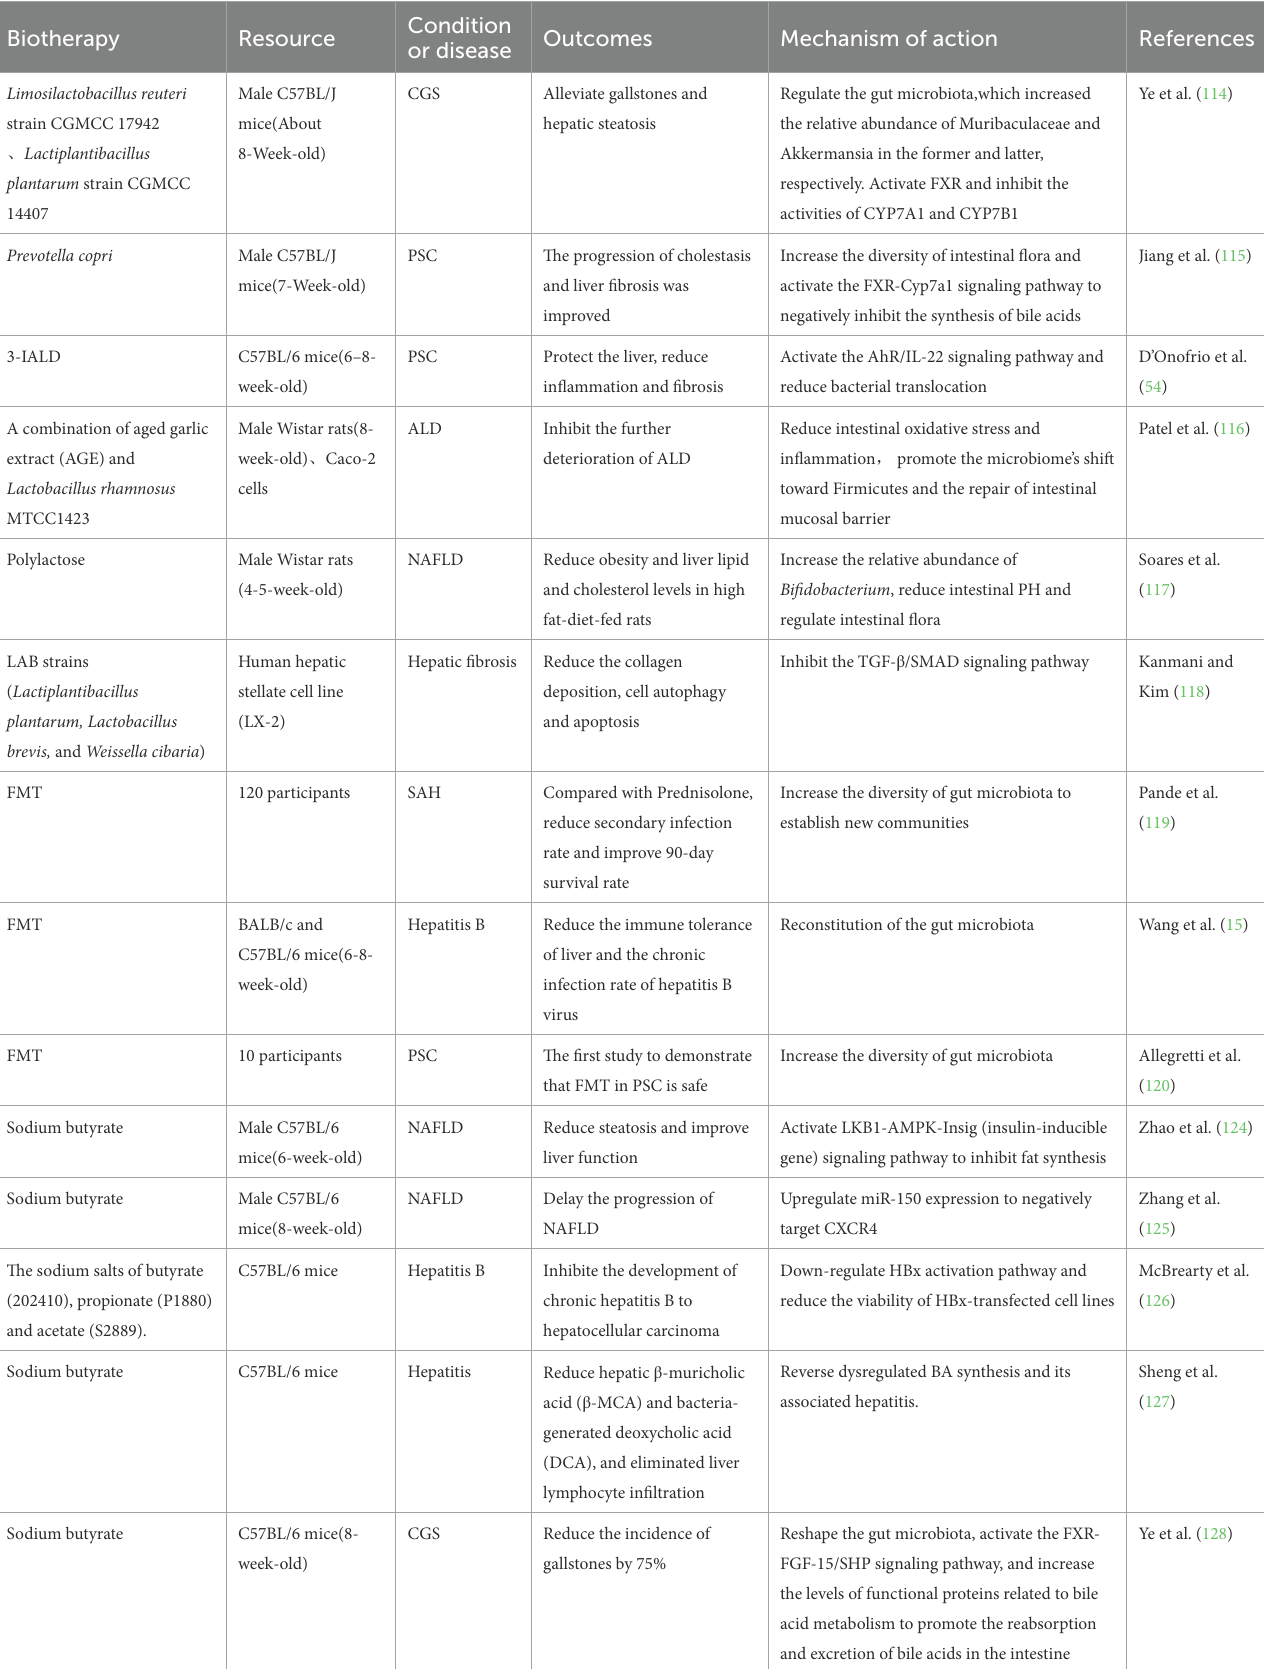
TABLE 1 Registered clinical trials and animal studies about biotherapy to treat liver and gallbladder disease.